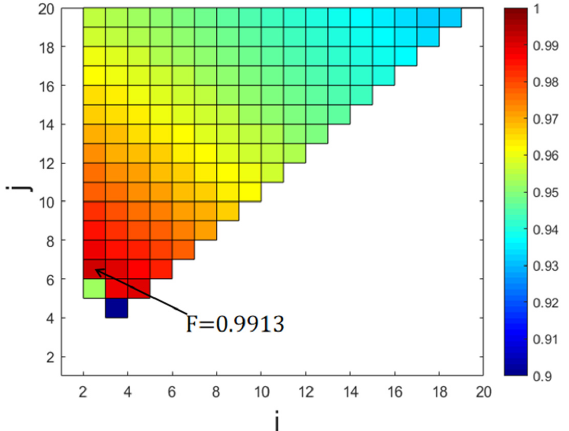
Figure 7. Influence of different 𝑘 values on F (background photon counts rate = 5 MHz) .